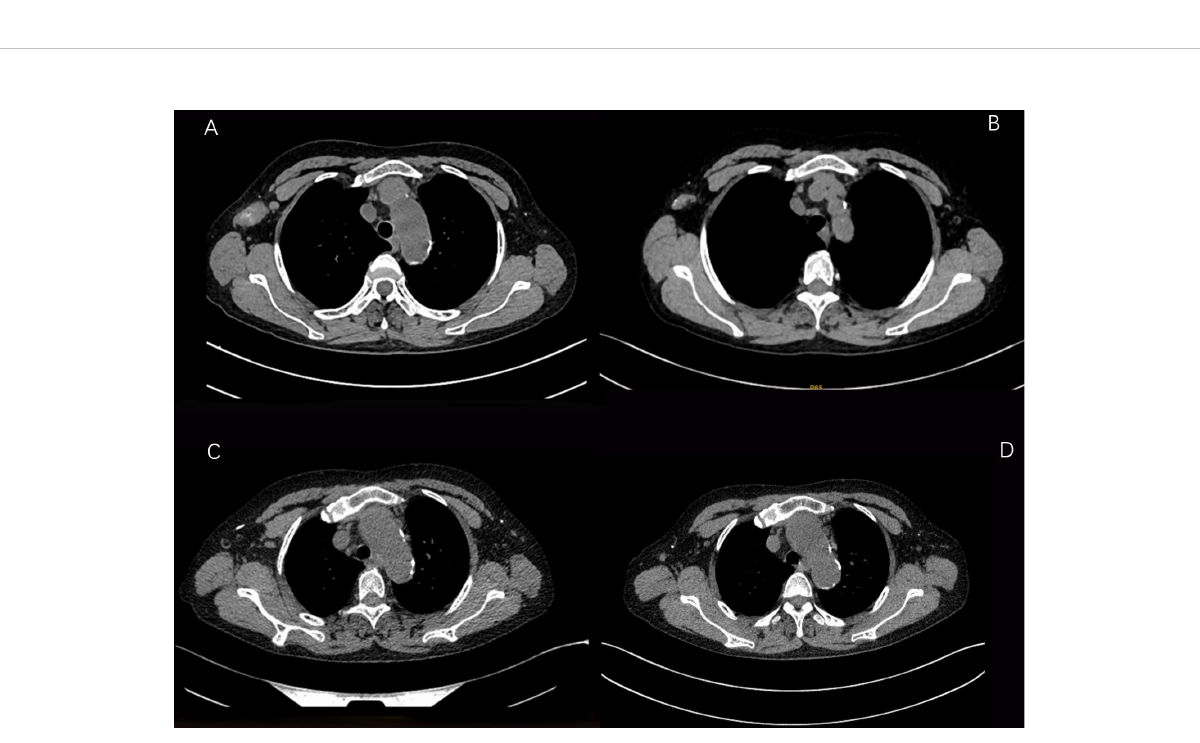
FIGURE 3 CT images of changes in the axillary lymph node lesions of the patient during the treatment period from August 6, 2021 to February 25, 2022 ( A :2021-08-06 B :2021-09-25 C :2021-12-17 D :